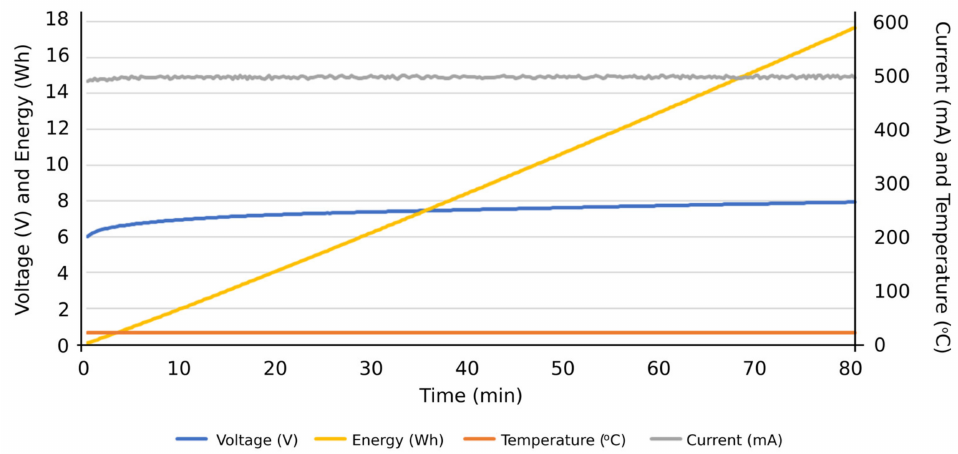
Figure 13. Results of a discharging cycle at constant intensity of 500 mA. Individual cell.